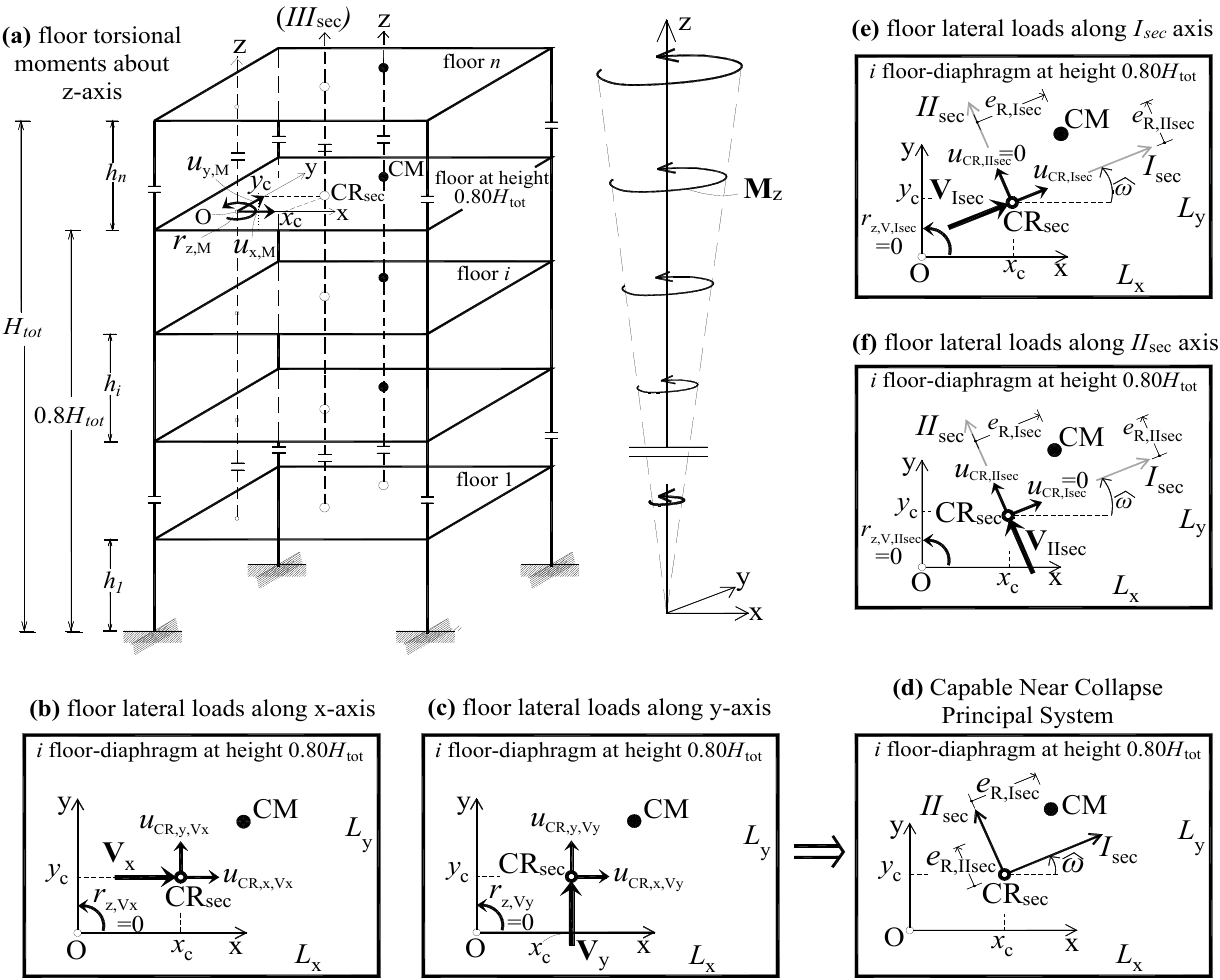
Figure 1. Three elastic analyses ( a – c ) for the determination of ( d ) “Capable Near Collapse Principal System CR sec ( III sec ) , I sec , II sec ” and two more elastic analyses ( e , f ) for the determination of “Capable Near Collapse torsional radii r I,sec , r II,sec ”, in the non-linear model ( EI sec ) of the multi-story RC